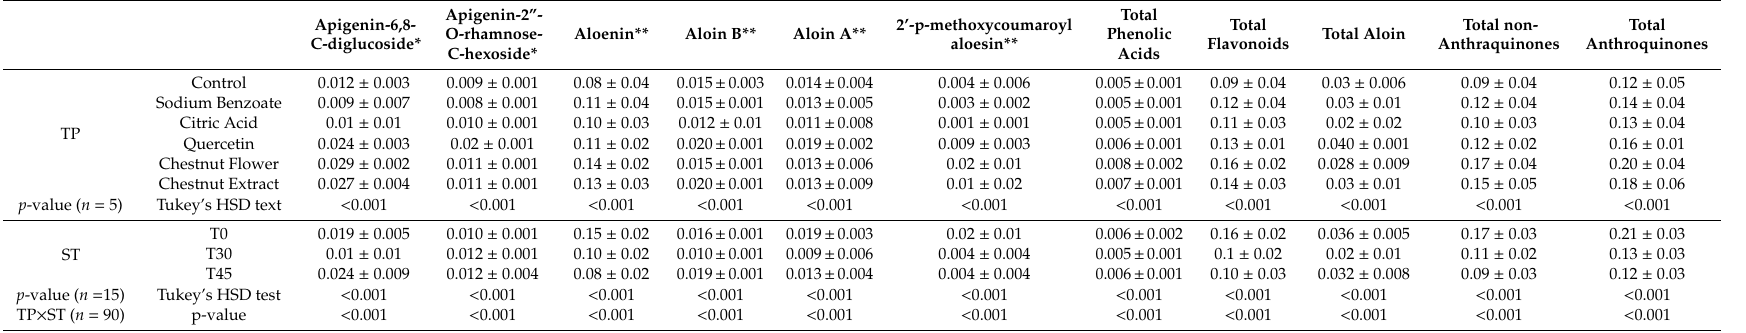
Table 4. Phenolic compounds tentatively identified in the di ff erent formulations, expressed in µ g / 100 g of fresh